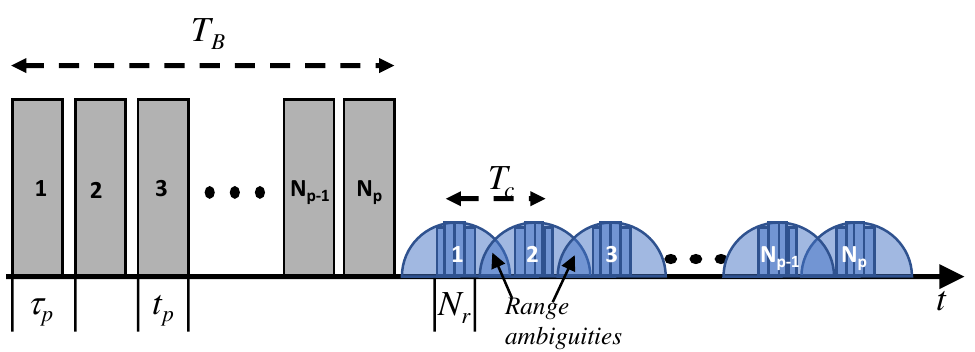
Figure 1. Burst-mode timing diagram conventions. N p chirped pulses with inter-pulse duration separation τ p (gray) are transmitted during a transmit cycle of duration T p , and the return pulses (blue) are range compressed so that the duration of the return pulses is dominated by the illuminated